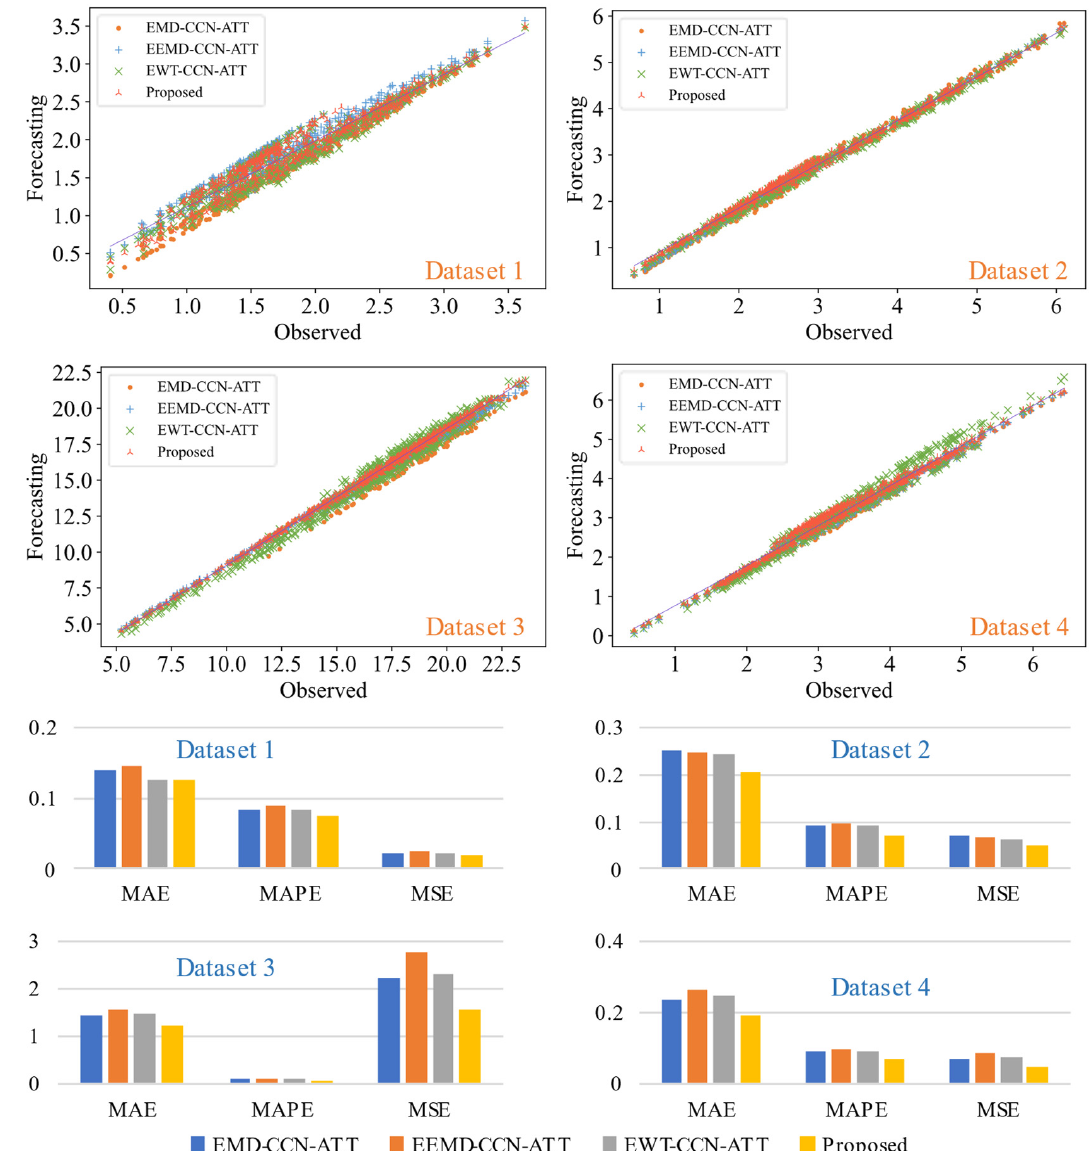
Figure 6. Forecasting results of models with different decomposition methods in four datasets.